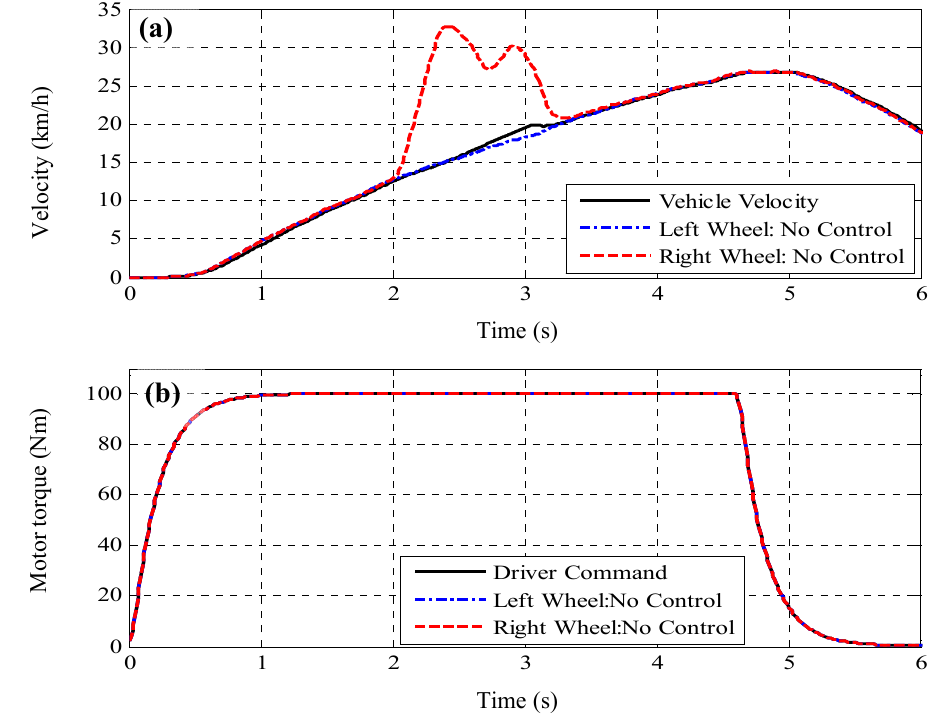
Figure 13. Experimental results without control: ( a ) Wheel velocity and estimated vehicle velocity; ( b ) Motor